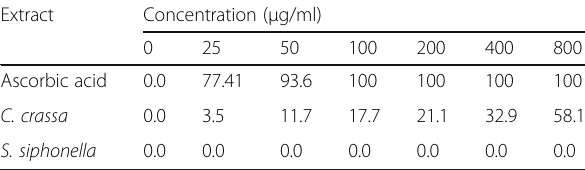
Table 3 DPPH % of different sponge crude extracts Extract